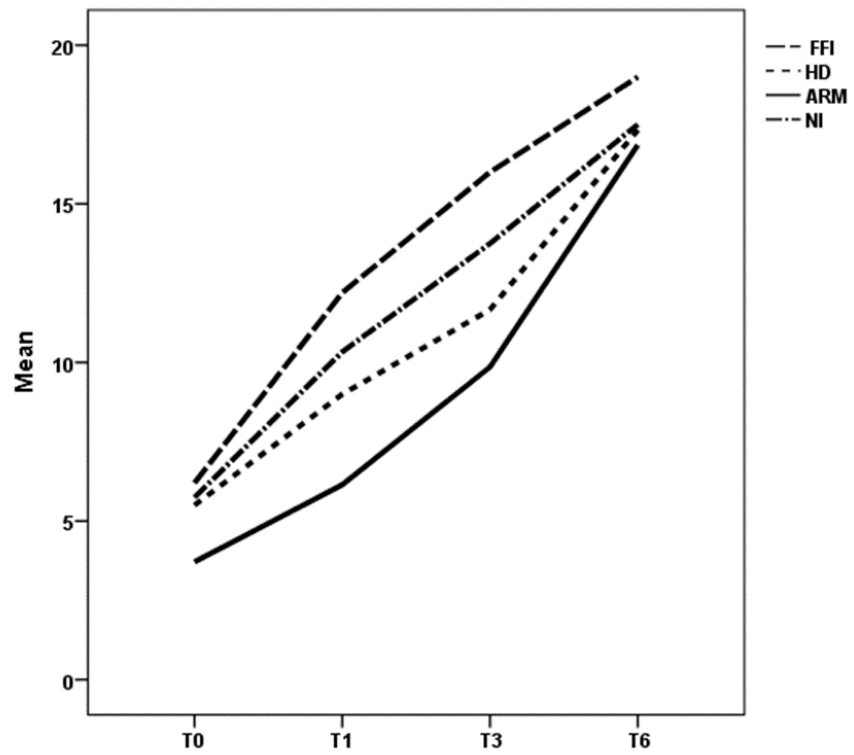
Figure 3. Trend of mean clinical scores at T0, T1, T3, and T6 for different groups. ARM: anorectal malformation; HD: Hirschsprung’s disease; NI: neurological impairment; FFI: functional fecal in- continence.